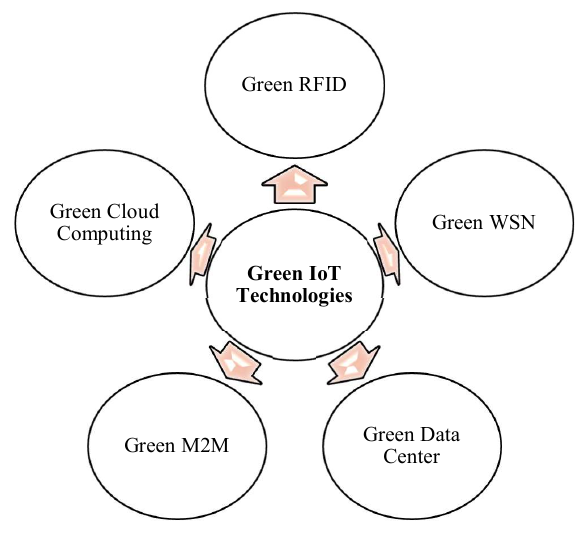
Figure 1. Green IoT